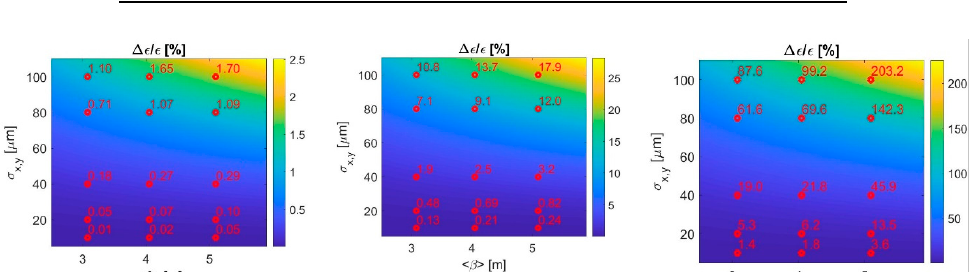
Figure 6. Percent projected emittance growth due to BBU through the linac downstream BC2 as function of the random rms misalignment of accelerating structures and average betatron function, for the bunch charge of (from left to right) 75, 150, and 300 pC. Beam and linac parameters are in Tables 3 and 5. The red dots and labels refer to PLACET results. Note the color scale spans over 2 orders of magnitude from low to high charge.